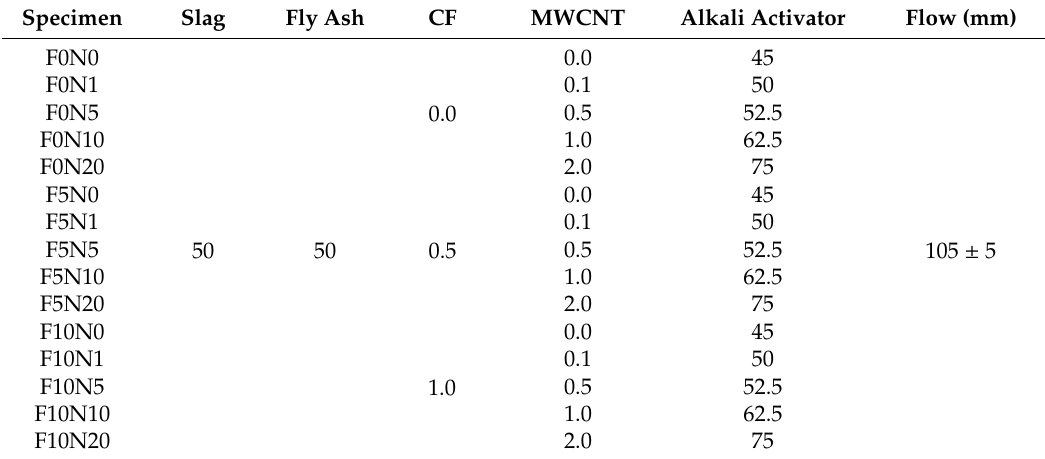
Table 3. Mix proportion of electrified alkali-activated slag mortar to be used for the present study (wt.%).